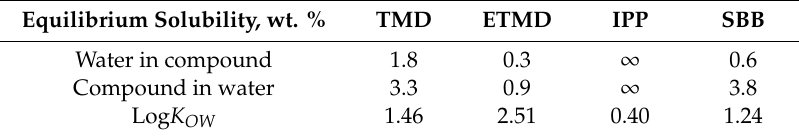
Table 10. The data on the water solubility of the renewable diol derivatives. Equilibrium Solubility, wt. %